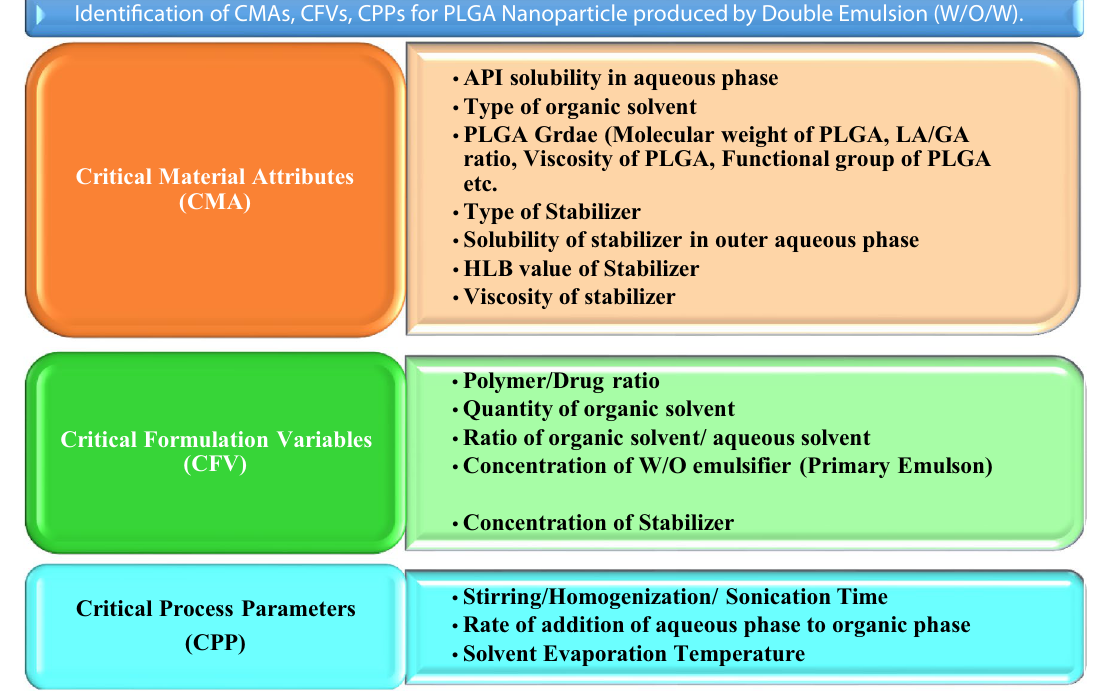
Fig. 5 CMAs, CFVs, and CPPs for PLGA nanoparticles produced by double emulsion